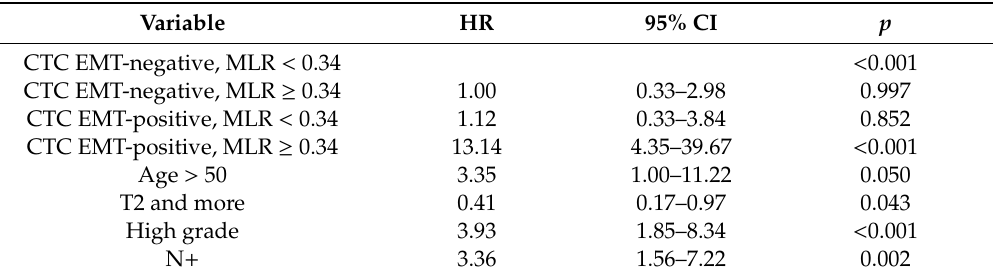
Table 4. Cox proportional hazard regression analysis for the association between CTC EMT and MLR status, clinical predictor variables, and PFS.